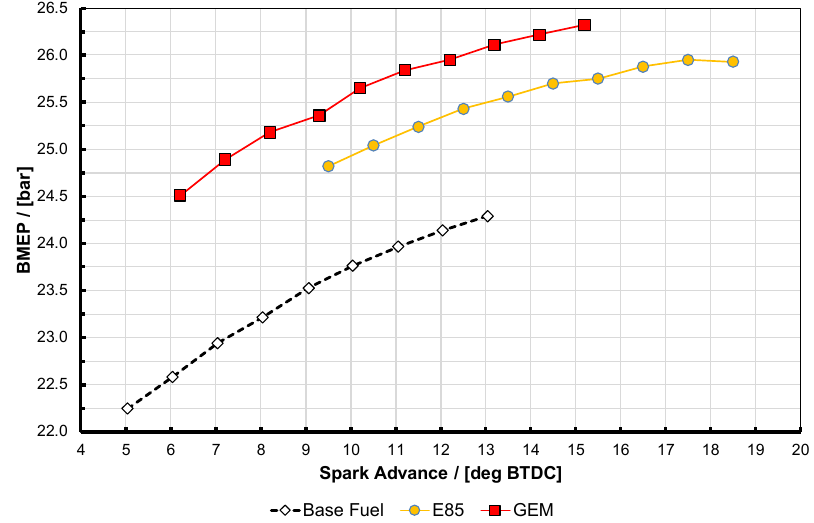
Figure 5. Ignition timing swings at test point D for E85 and the GEM blend compared with the base 95 RON gasoline fuel. These results are all at a matched engine speed of 3000 rpm and with 60 °C temperature and 140 kPa gauge pressure in the plenum with 10% cooled EGR. Note that the engine load (i.e., BMEP) varied with spark advance. See text for discussion on accuracy of the results.